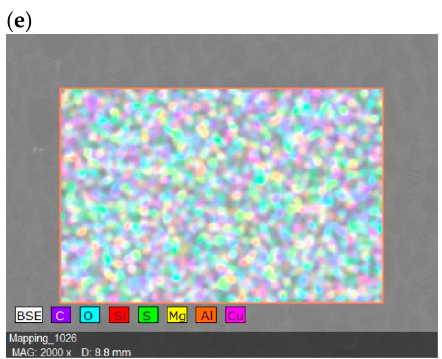
Figure 5. EDX qualitative analysis of cloisite (Si) distribution in SP/e-spunCL nanocomposite membranes ( a ) SP/e-spunCL10, ( b ) SP/e-spunCL15, ( c ) SP/e-spunCL20, ( d ) SP/e-spunCL25, ( e ) SP/e-spunCL30. Table 3. EDX quantitative analysis of dispersion of cloisite15A in SP/e-spunCL nanocomposite membranes.